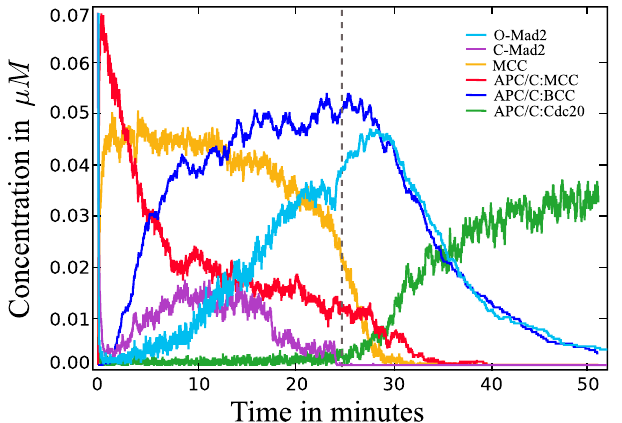
Figure 4. Spatial concentration over time for the labeled species. The dashed line indicates attachment of the last kinetochore. The mainly difference to the ODE curves is the slower activation of APC/C:Cdc20 and the presence of fluctuations in all